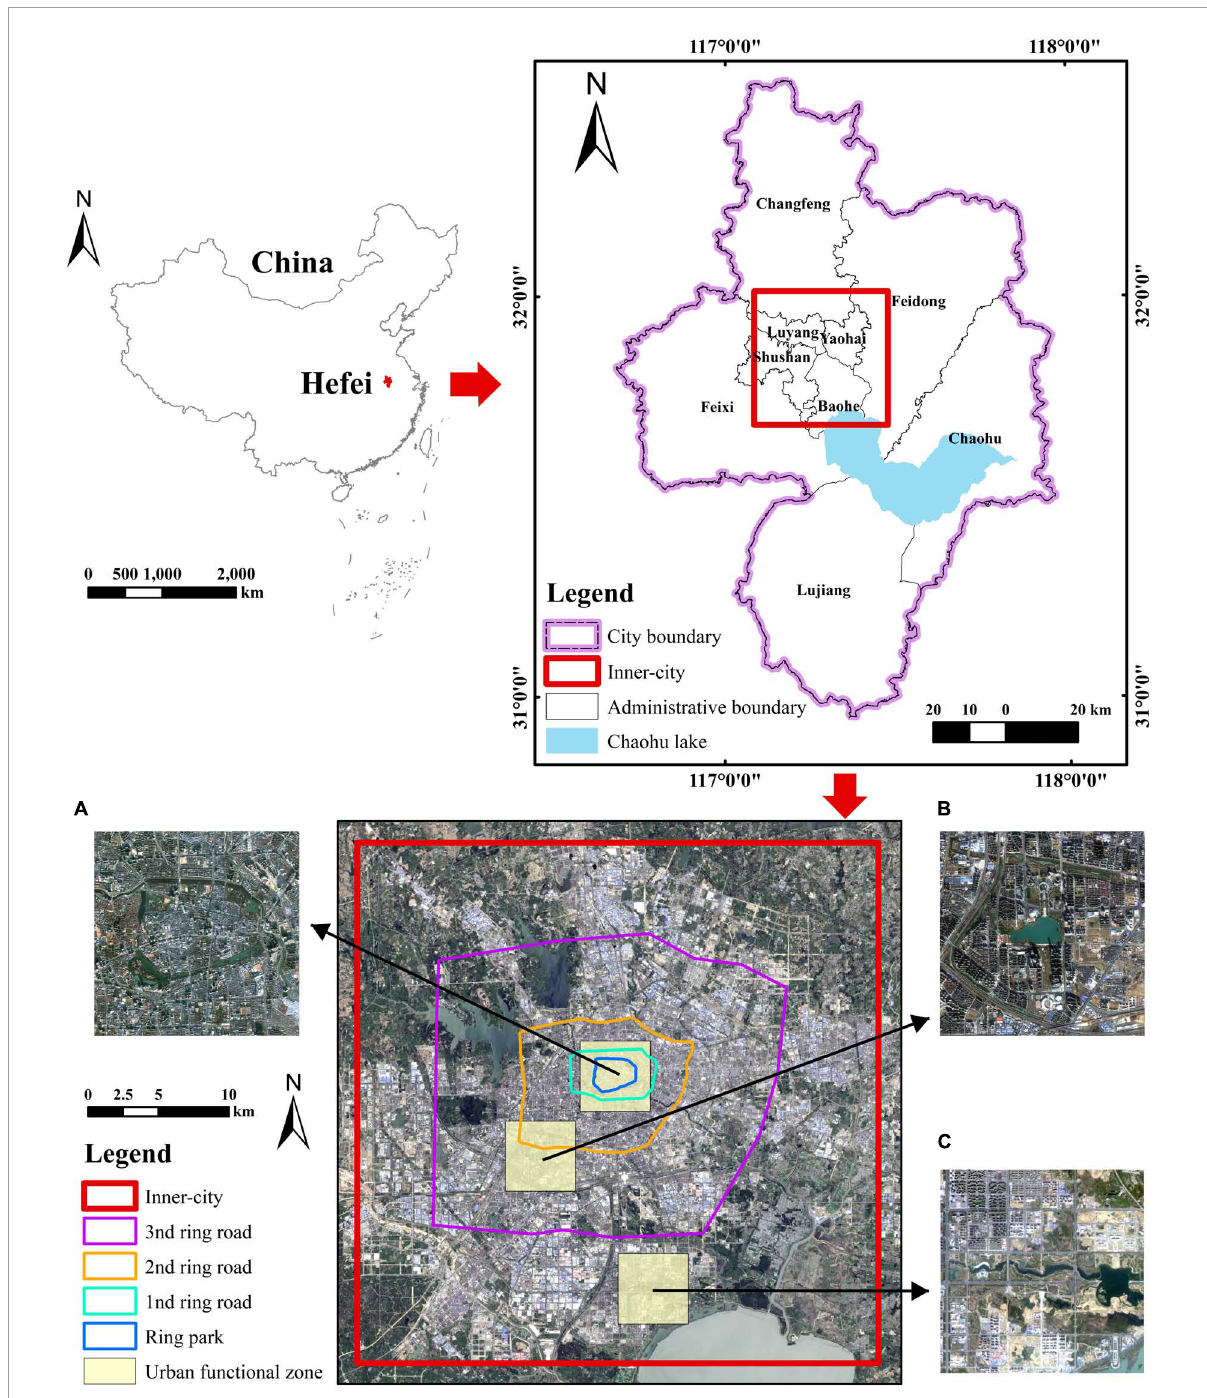
FIGURE1 Location of the study area. (A–C) Ring Park area, Swan Lake Park area, and Tangxi Lake Park area, respectively.